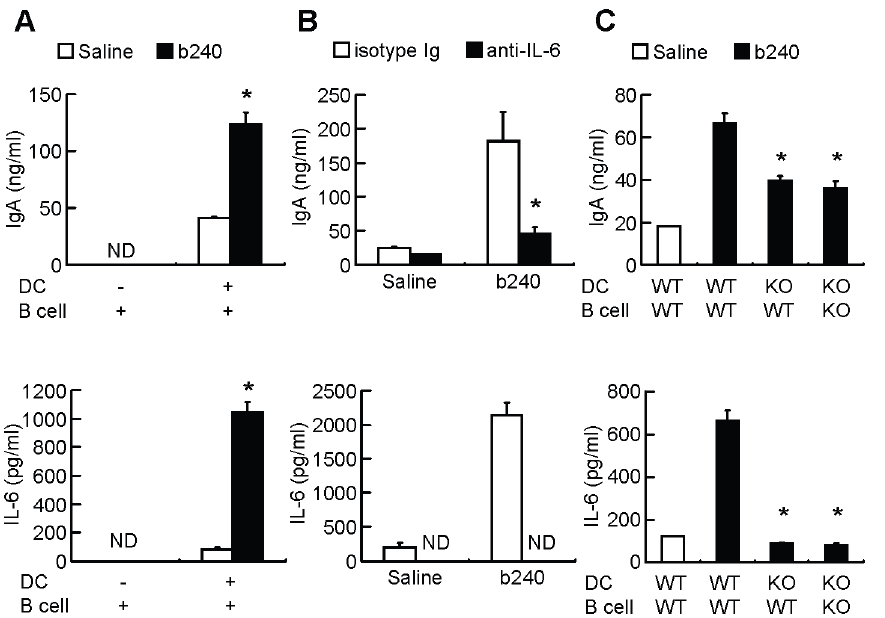
Figure 5. Role of PP DCs in the IgA-enhancing ability of b240. (A, C) In the presence (black) or absence (white) of heat-killed b240 (1.6 6 10 6 counts), (A) purified WT PP IgD + cells (2 6 10 5 cells/well) were cultured with or without purified WT PP CD11c + B220 2 DCs (1 6 10 5 cells/well), (B) purified WT PP CD11c + B220 2 DCs and purified WT PP IgD + B cells were co-cultured with (black) or without (white) anti-IL-6 mAb (10 m g/ml) in the presence or absence of heat-killed b240 (1.6 6 10 6 counts), and (C) purified WT or TLR2 2 / 2 PP CD11c + B220 2 DCs and purified WT or TLR2 2 / 2 PP IgD + B cells were co-cultured for 7 days. IgA and IL-6 in the culture supernatants were determined by ELISA and CBA, respectively. Data are expressed as mean 6 SEM (n=1–3). ND, not detected. * P , 0.05 versus (A) saline group by Welch’s t -test, (B) isotype Ig group by Student’s t- t est, (C) WT DCs + WT B cells + b240 co-culture by Dunnett’s test. Data are representative of 2 independent experiments producing similar results.